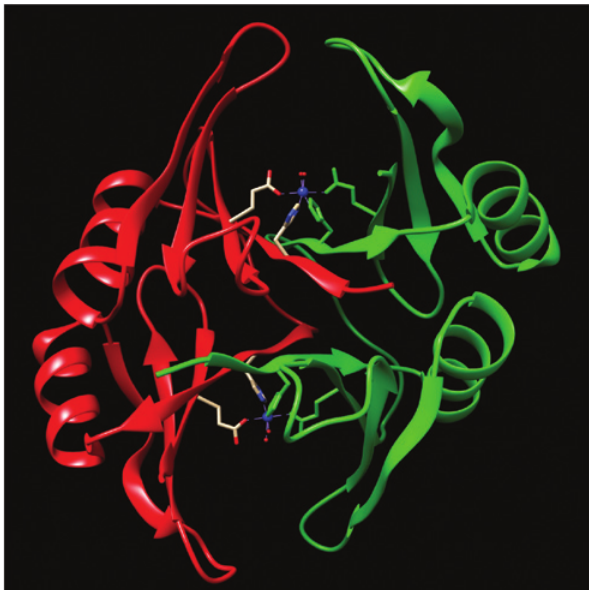
Figure 4: Ribbon representation of E. coli glyoxalase I. The two subunits of the enzyme are colored green and red. Active site hexacoordinate Ni 2 + is shown as a blue sphere with amino acid side chains from both subunits contributing to the binding of each active site nickel atom. Two water molecules shown as red spheres complete the active site metal coordination. (PDB